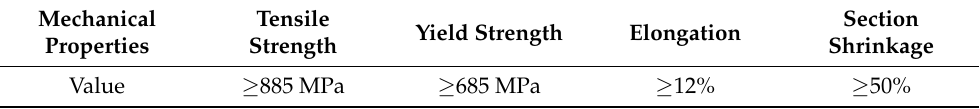
Table 2. Mechanical properties of 20CrMo steel.